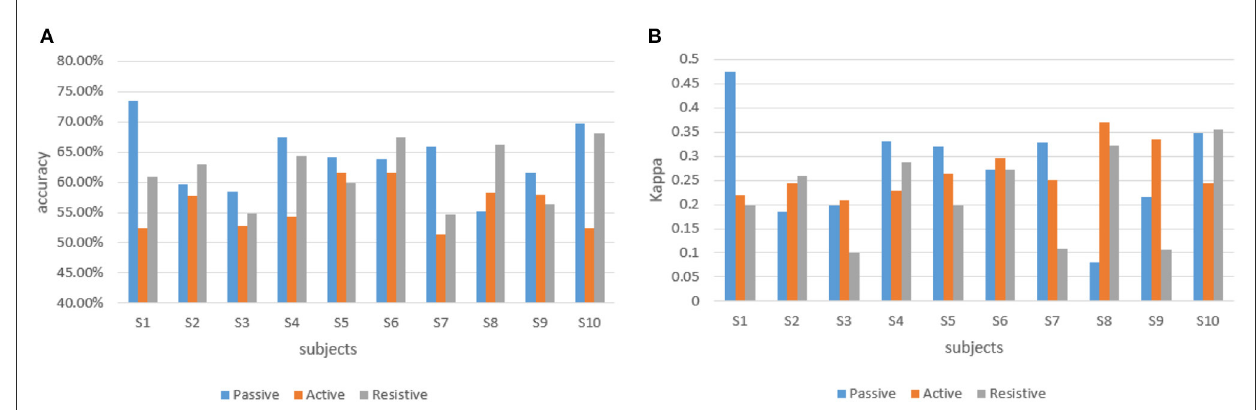
FIGURE6 The classification accuracy and Kappa coefficient of 10 participants in three training stages under the online experiment. (A) The classification accuracy of 10 participants. (B) Kappa coefficient of 10 participant.